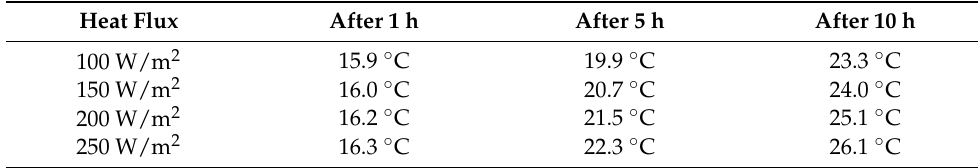
Table 3. The average temperature on the surface of the wall for CW03.